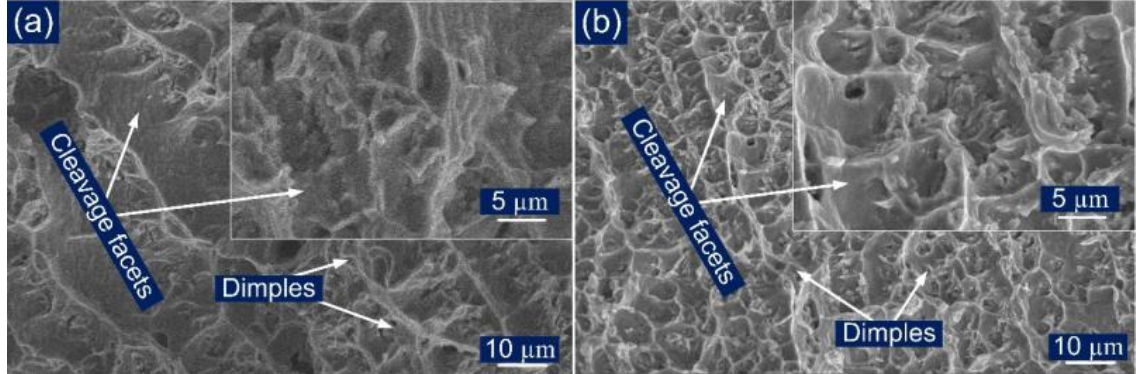
Figure 17. Typical fracture surfaces of the impact tested specimen for weld metal ( a ) AW, ( b ) PWHT.